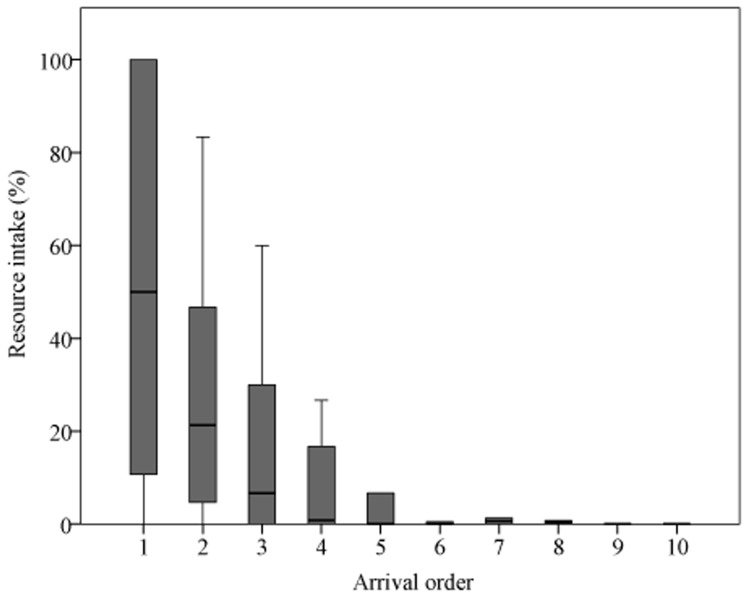
Individual resource intake (in percent of total volume available at the platform) in relation to arrival order.Shown are medians, 25–75% quartiles (box) and ranges (whiskers). N = 204.